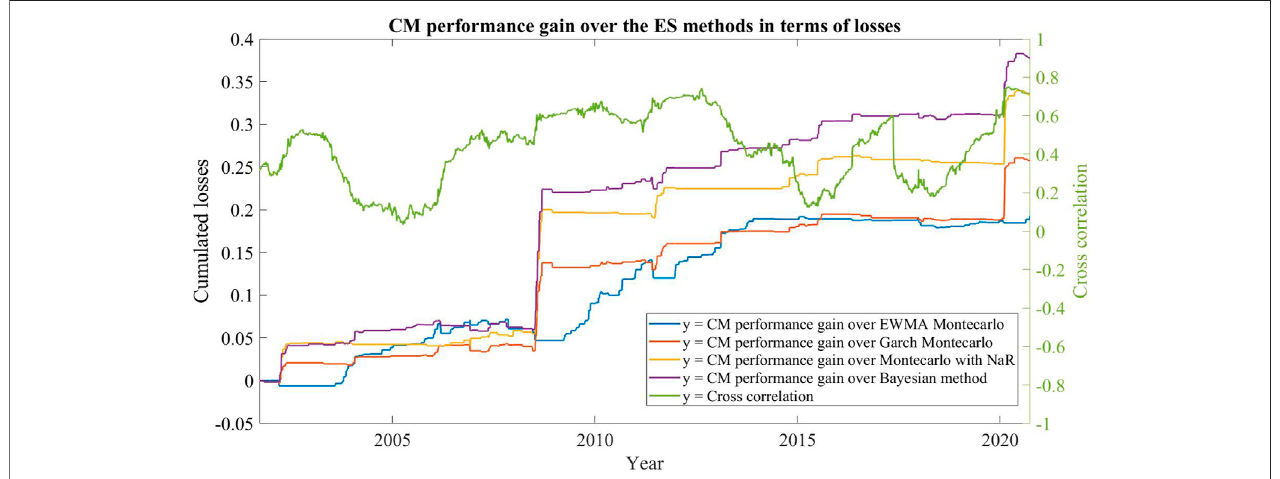
FIGURE 4 | Commitment machine performances and asset